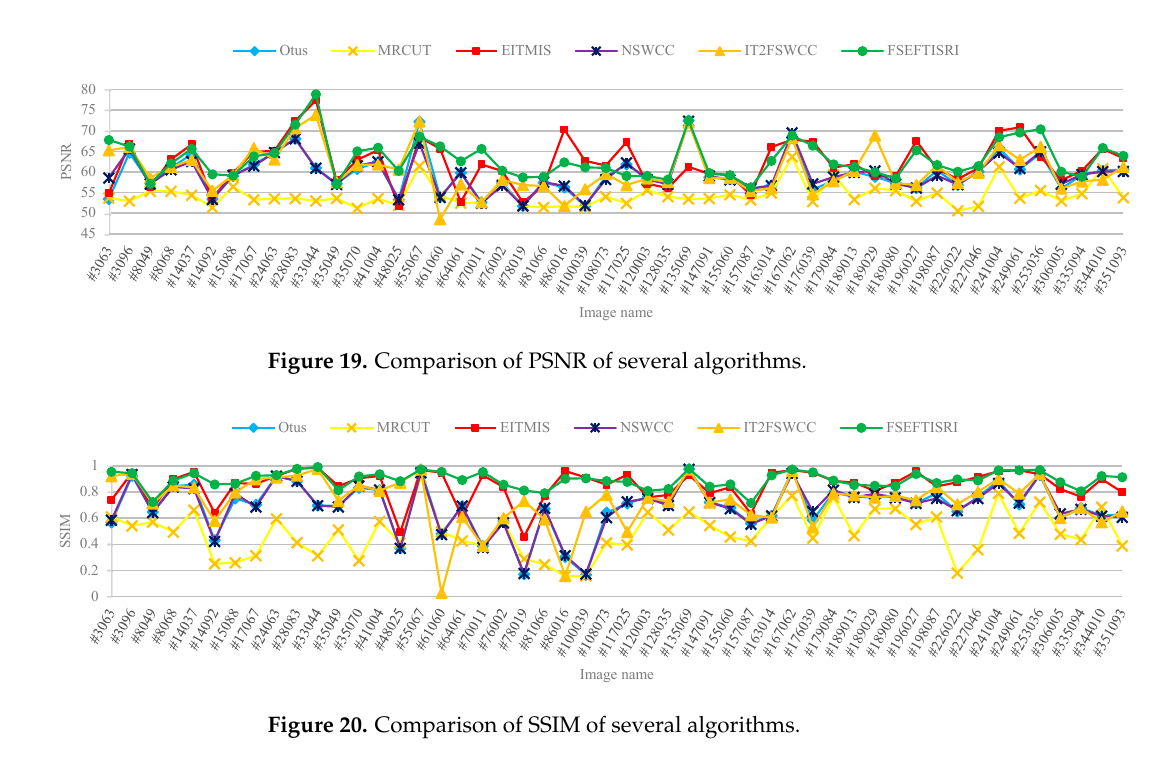
Figure 18. Comparison of FSIM of several algorithms.